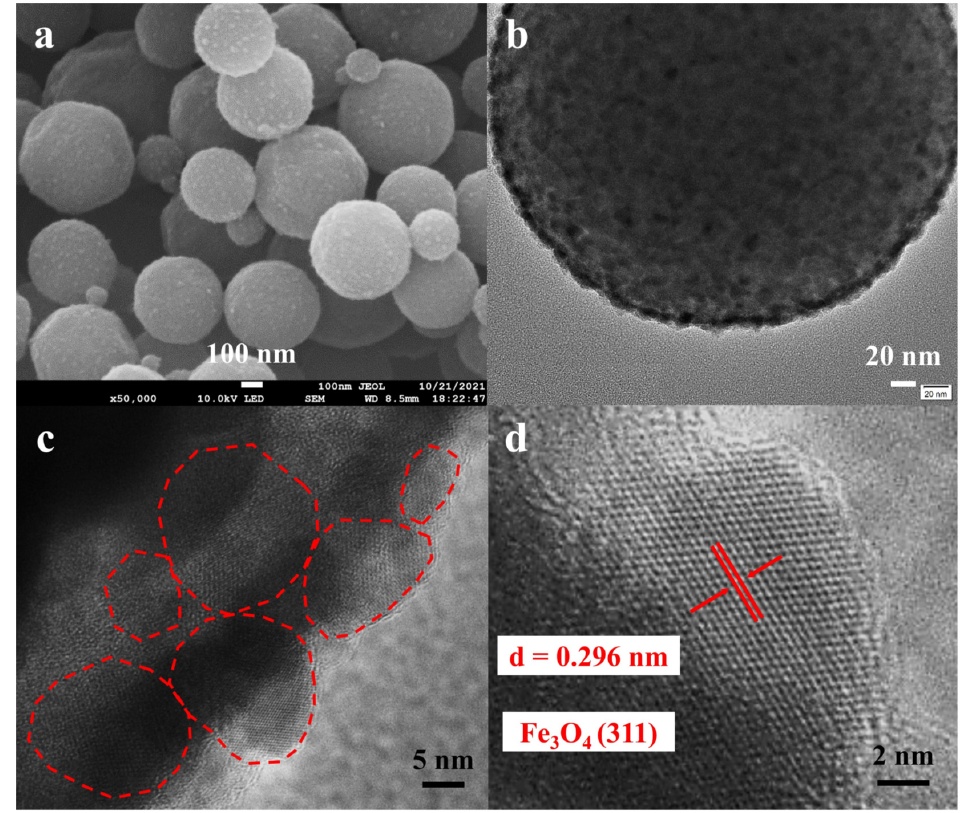
Figure 2. FESEM image ( a ), TEM images under different magnifications ( b , c ) and HRTEM image ( d ) of the Fe 3 O 4 @C sample.